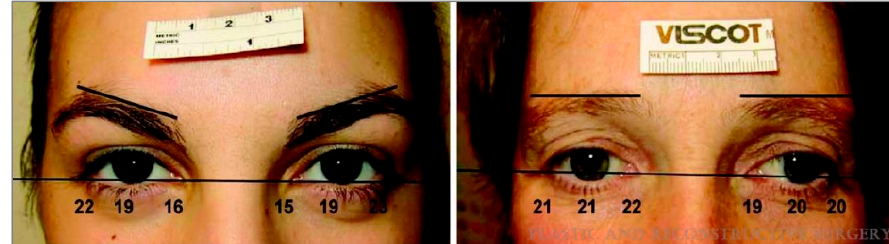
Figure 5. The difference in the tilt of the brow changes from apex lateral ( left ) to apex neutral ( right ). Typical outcomes for patients aged 20 to 30 ( left ) and 50 to 60 ( right ) are displayed. Younger individuals have a low medial brow with an apex lateral configuration. Older individuals’ higher medial and middle brows lead to a flattened look. For each position measured, measurements to the top of the brow edge are shown [35].